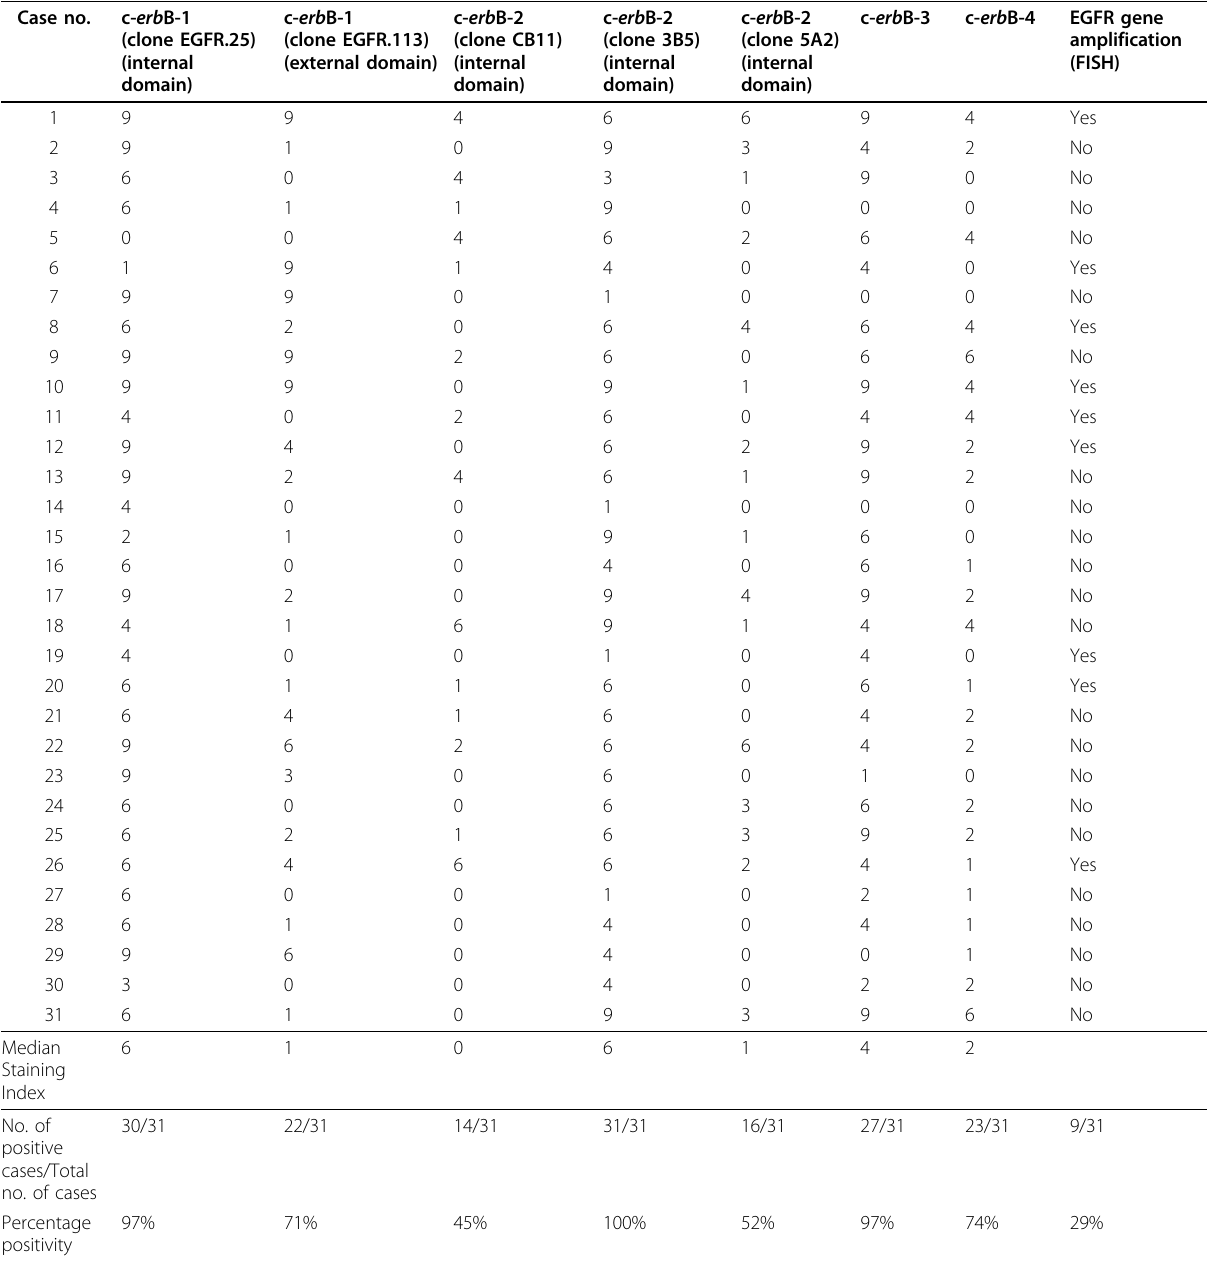
Table 3 Immunohistochemical and FISH data Case